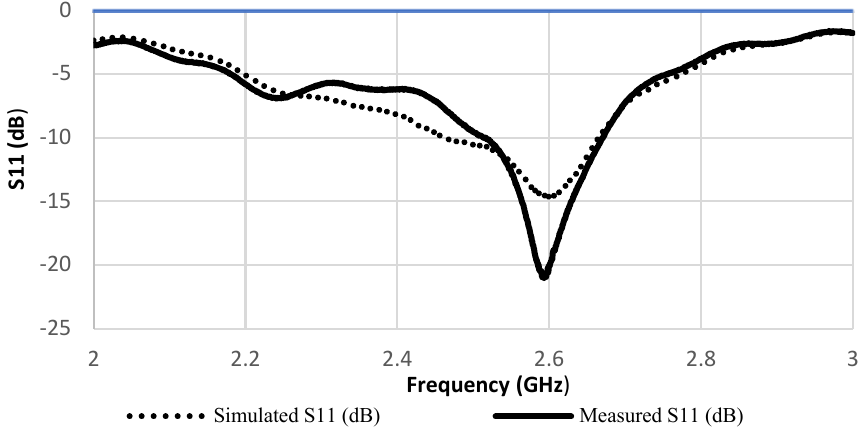
Figure 7. Simulated return loss with the presence of the simulated human arm model versus measured return loss on a real human arm of the same radius 45 mm as simulated.